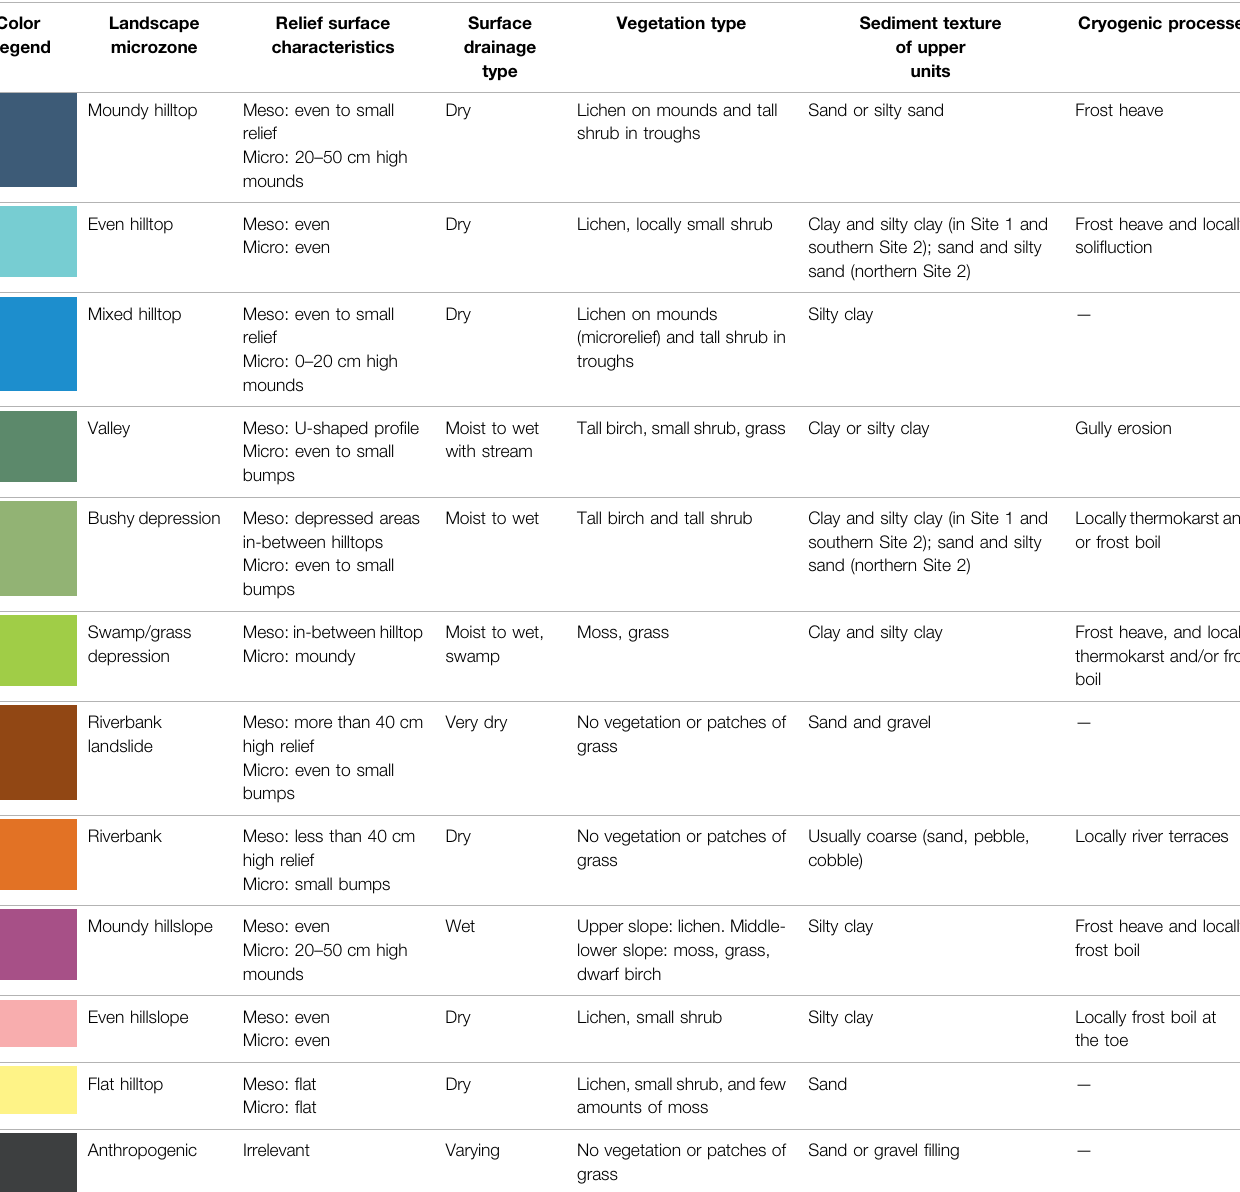
TABLE1| Characteristicsofthe12differenttypesoflandscapemicrozonesidenti fi edintheKhanoveyarea(Site1andSite2)bythegeocryologicalsurvey.Themaintypesof surface relief, drainage, vegetation, surface sediment texture classi fi cation, and cryogenic processes are reported. Color Landscape legend